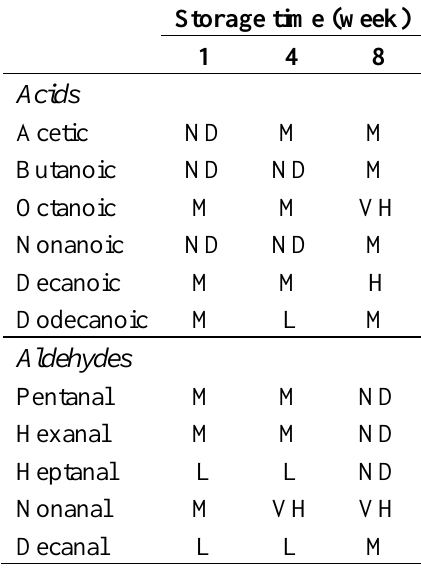
Table 5. Relative abundance of volatile compounds in Queso Fresco, arranged by compound class, and their variation with storage time at 4 °C. ND = not detected, L = 0–9000, M = 10,000–49,000, H = 50,000–99,000, VH = above